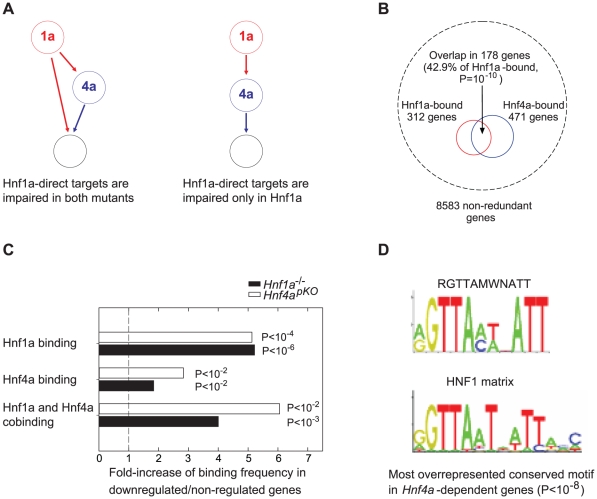
Expression of Hnf1α targets is impaired in Hnf4a-deficient islets.(A) Alternate models of Hnf1α and Hnf4α network structures that could potentially underlie the similar transcriptomes in Hnf4apKO and Hnf1a+/− islets, and expected functional perturbation of Hnf1α bound genes in each case. (B) The analysis of previously reported [8], [11] mouse liver binding datasets showed that Hnf1α and Hnf4α preferentially bind the same genes, as reported in human islets and liver[6]. Hypergeometric distributions were tested to calculate significance values. (C) Hnf1α, Hnf4α and Hnf1α/Hnf4α binding were enriched in genes that were significantly downregulated 2-fold in Hnf4apKO and Hnf1a
-/- islets. Hypergeometric distributions were tested to calculate significance values. (D) Most significant over-represented evolutionary conserved sequence element in 10 Kb surrounding transcription start sites of genes that were downregulated in Hnf4apKO islets. The canonical HNF1 matrix is shown below. Motifs matching Hnf4α, or Hnf1α and Hnf4α binding sequences were also overrepresented in genes downregulated in Hnf4apKO and Hnf1a
-/- islets, respectively (not shown).